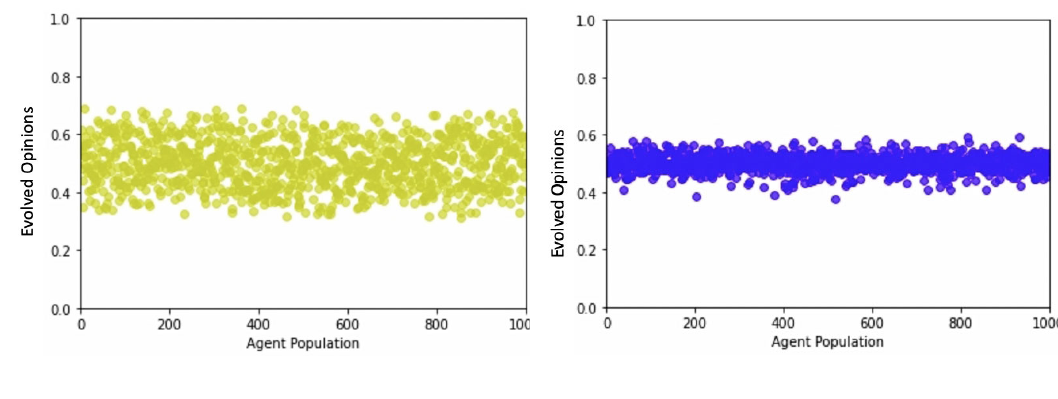
Fig. 5 The evolved opinions with different stubbornness distributions